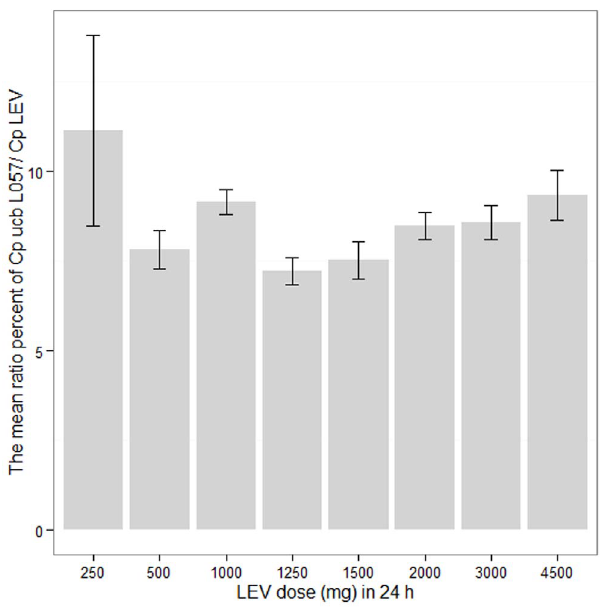
Figure 3. Mean and standard error of mean (SEM) of the ratio percent of plasma concentrations of UCB L057/LEV at various dosing regimens.